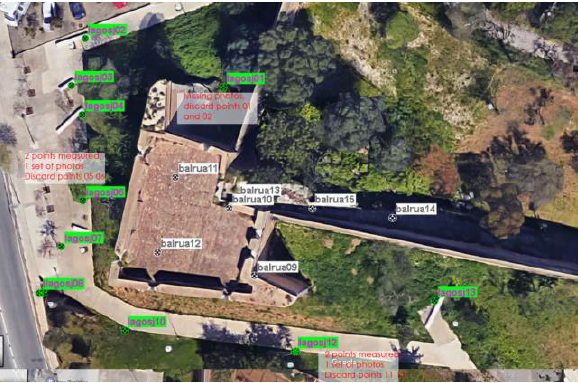
Figure 2. GPS control points surveyed in “Baluarte das Freiras” Reference points were set on natural features of the site that could be easily identified in laser scanning point clouds and in photographs. It was collected a total of 57 GPS points. A TLS survey was done in the accessible areas from ground stations (fig. 3) which had public access.